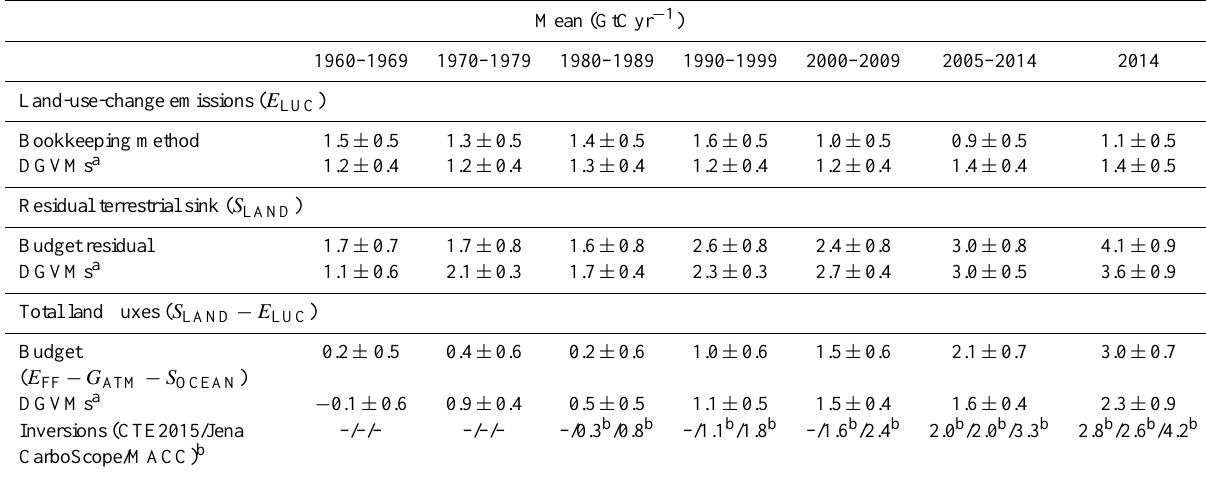
Table 7. Comparison of results from the bookkeeping method and budget residuals with results from the DGVMs and inverse estimates GtCyr − 1 . The DGVM uncertainties represents ± 1 σ of the decadal or annual (for 2014 only) estimates from the 10 individual models; for the inverse models all three results are given where